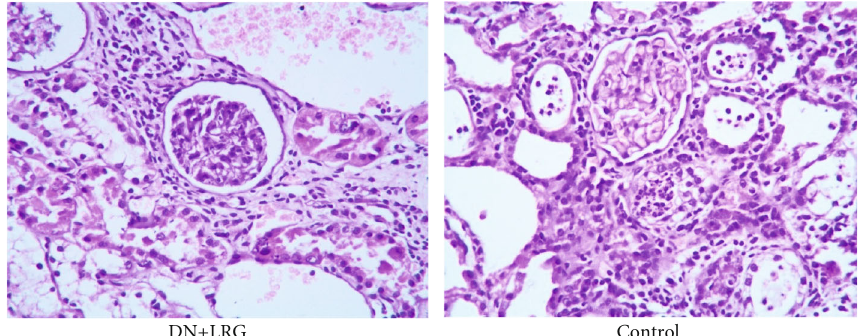
Figure 11: Hematoxylin eosin staining of the kidney ( × 400). Control: diabetic nephropathy group; DN+LRG: diabetic nephropathy +liraglutide